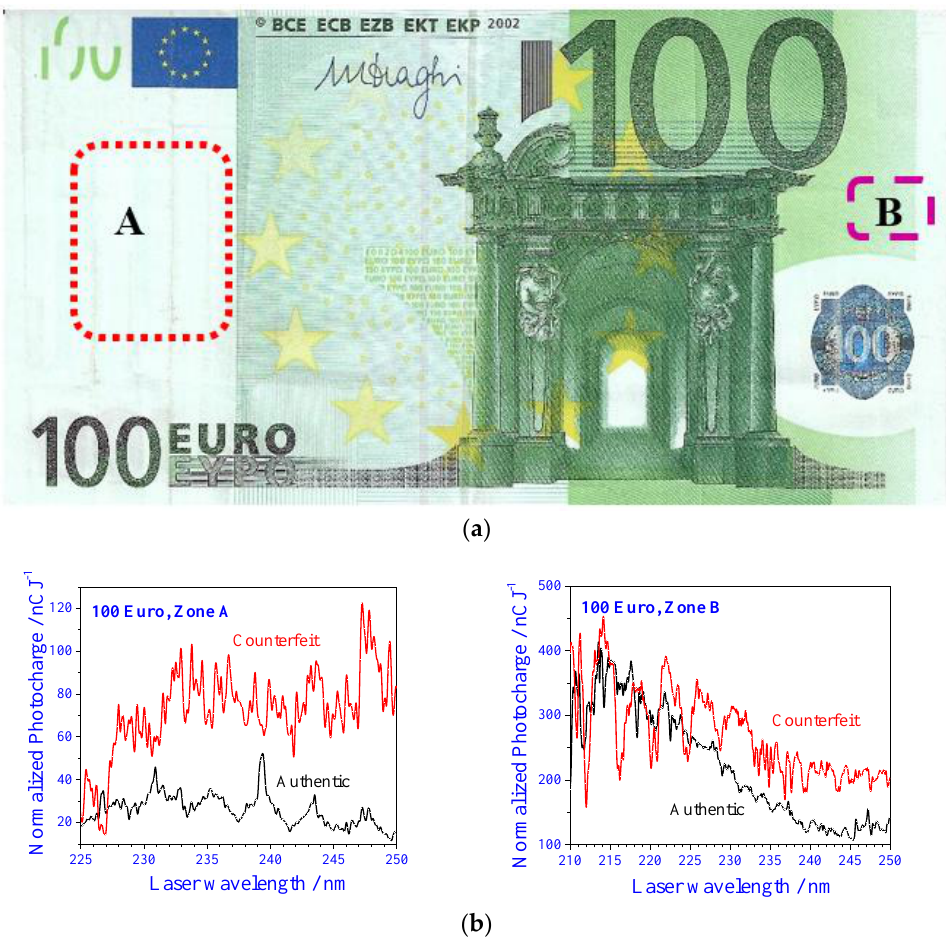
Figure 3. ( a ) The two tested zones in 100 Euro banknotes; ( b ) MEES spectra of 100 Euro banknotes in Zone A (left) and in Zone B (right). Zone A (left) and in Zone B